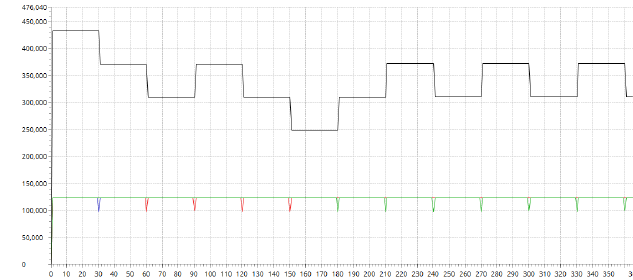
Figure 24. Available Inventory of Scenario II